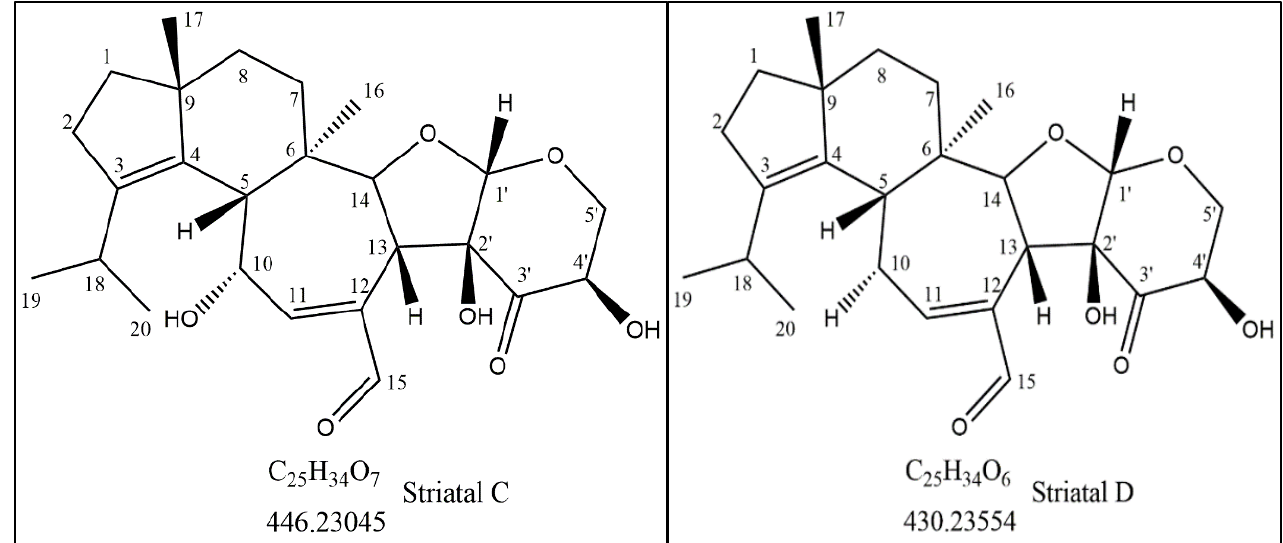
Figure 2. Structure of striatal C at 15.8 min and striatal D at 18.2 min in the HPLC chromatogram.